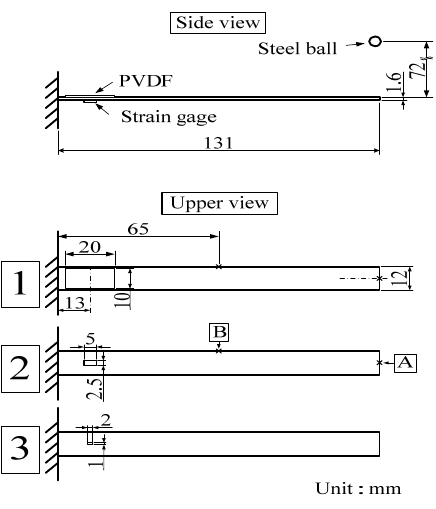
Figure 8. Setup of the second part experiment.